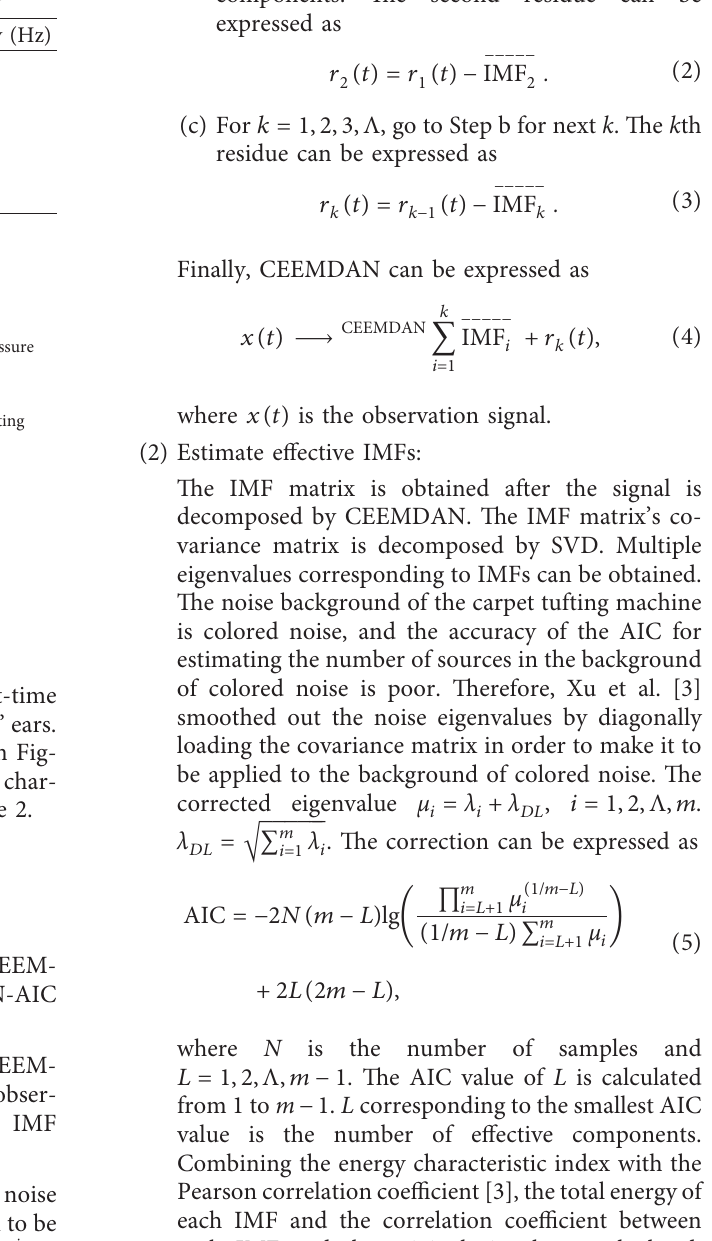
Table 1: The main vibration frequencies of the parts.